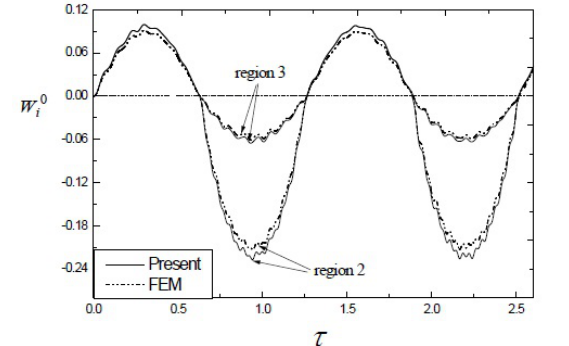
Fig. 2. Nonlinear dynamic response curves of the mid-span point for the segments 2 and